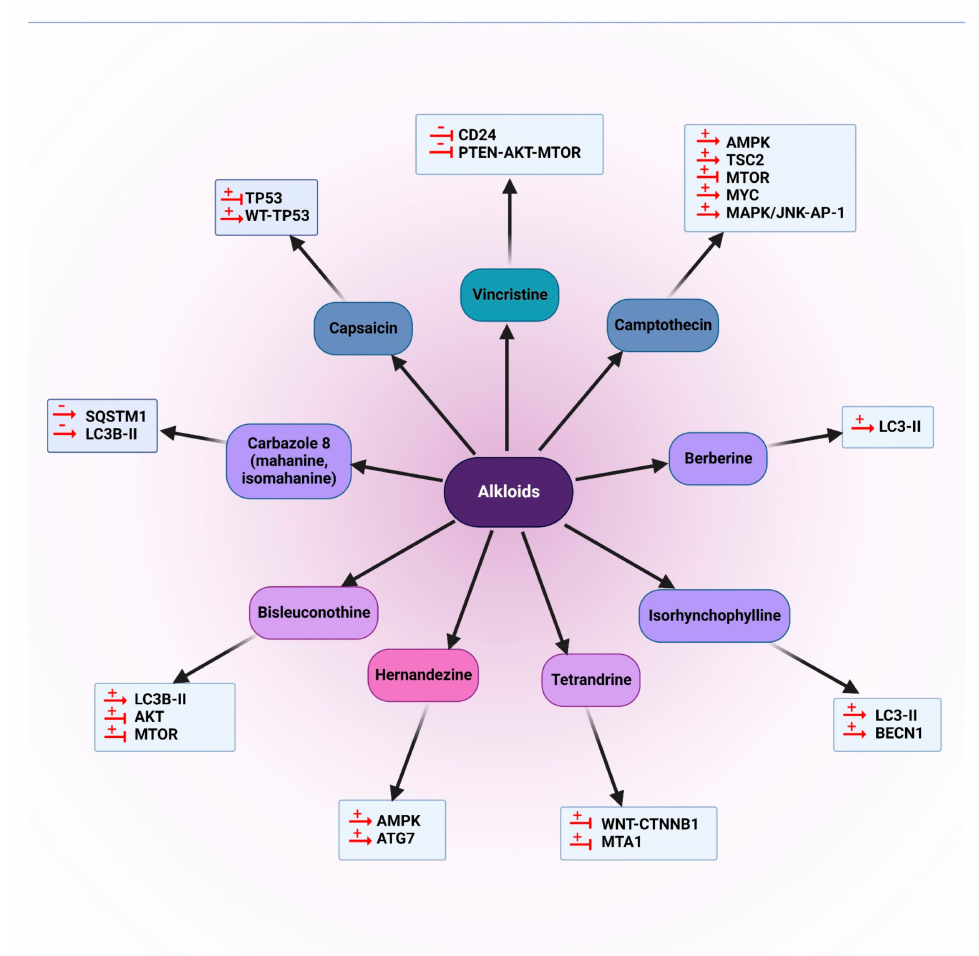
Figure 7. The schematic role of alkaloids on different proteins involved in the autophagy pathway. Alkaloids regulate autophagy in different ways. Vincristine and carbazoles have been demonstrated to inhibit autophagy by suppression of CD24, suppression of the PTEN-AKT-MTOR pathway and enhancement of SSQTM1/p62. Other alkaloids induce autophagy via activation of AMPK, TSC2, MAPK/JNK-AP-1 and BECN1, and enhance MYC/c-Myc, LC3-II and ATG7 expression. Moreover, inhibiting the AKT-MTOR pathway has a key function in induced autophagy by alkaloids. Moreover, another alkaloid named tetrandrine induces autophagy by suppressing the WNT-CTNNB1/ β -catenin pathway and decreasing MTA1 expression. → : Indicates activation or an increase in the mentioned protein expression. : Indicates deactivation or a decrease in the mentioned protein expression. − and +: Indicate the effect of the proteins on different pathways ( − means negative effect and + means positive effect). The figure was created with BioRender.com. Licensing Right VD24OB6Q8E, 21 November